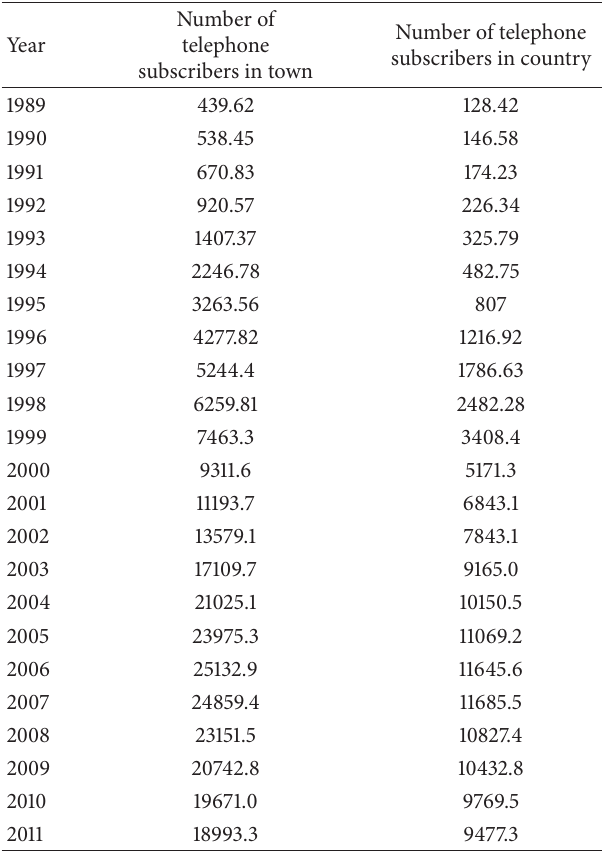
Table 2: The data of telephone subscribers in the year